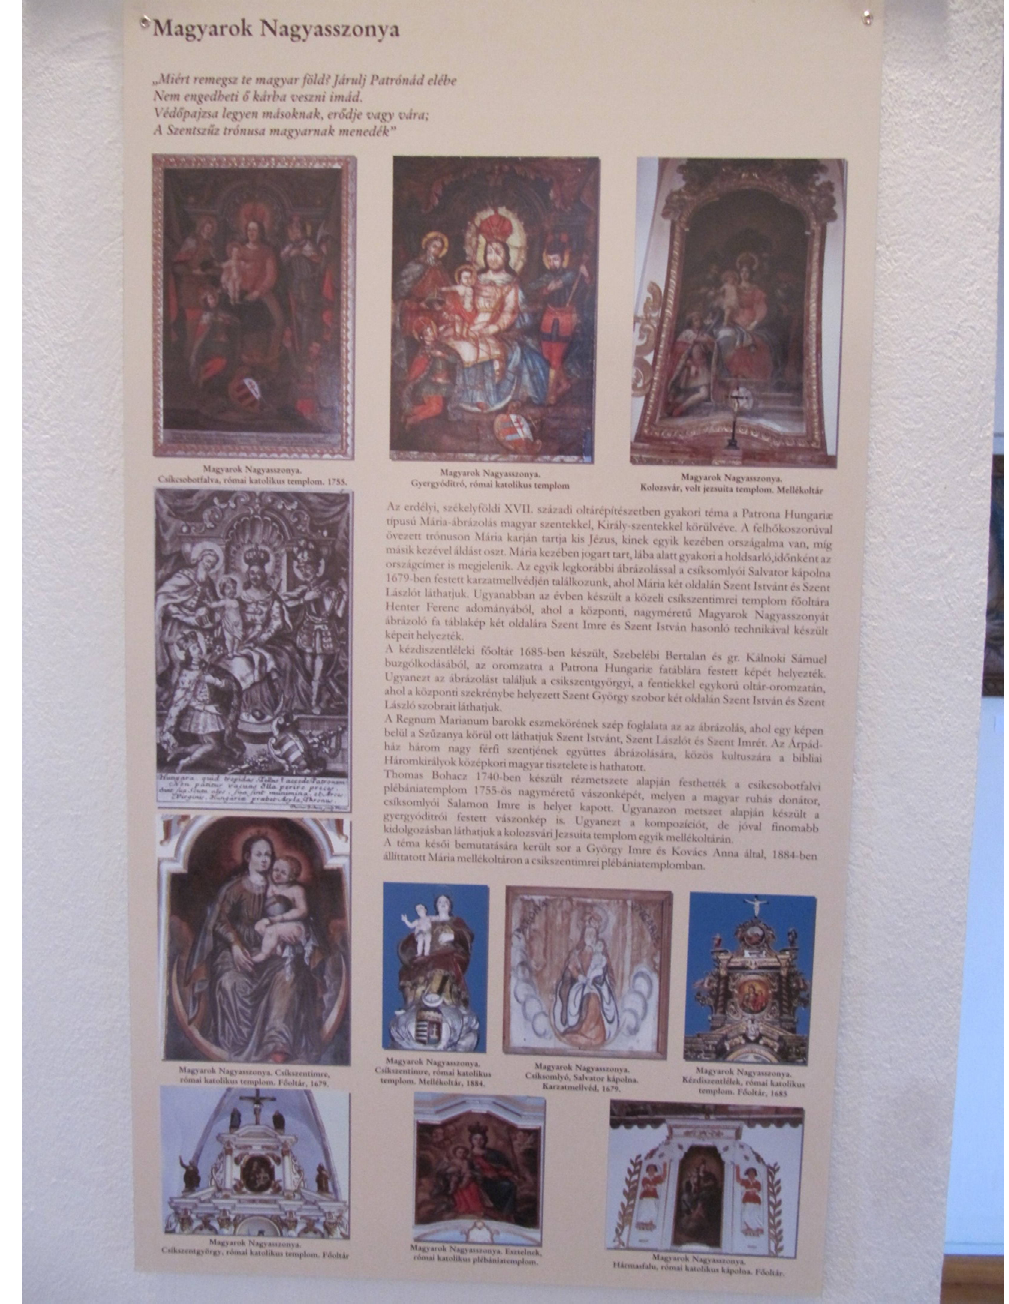
Figure 3. Great Lady of Hungarians Placard.